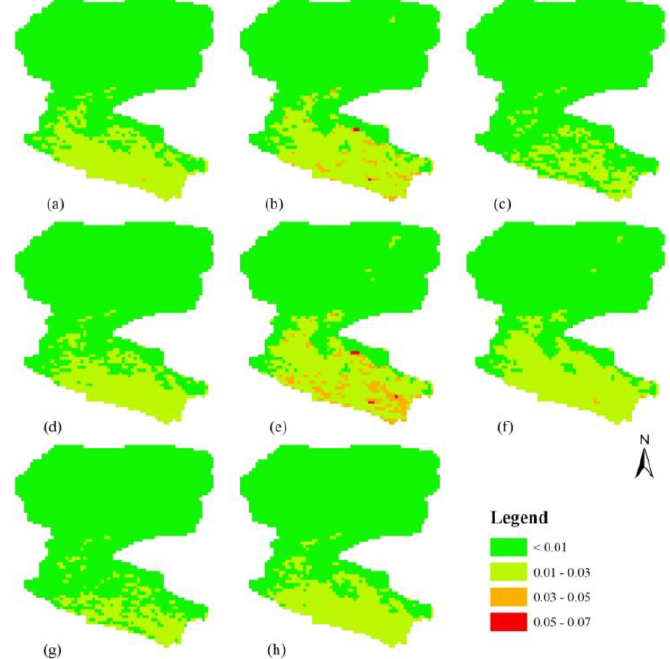
Figure 6. Root mean square error (RMSE) values of GIMMS NDVI for the eight techniques: ( a ) the asymmetric Gaussian (A-G) technique; ( b ) the modified-best index slope extraction (M-BISE) technique; ( c ) the changing-weight filter (CW) technique; ( d ) the double logistic function (D-L) technique; ( e ) the iterative interpolation for data reconstruction (IDR) technique; ( f ) the mean value iteration (MVI); ( g ) the Savitzky-Golay filter (S-G) technique; and ( h ) the Whittaker smoother (WS)